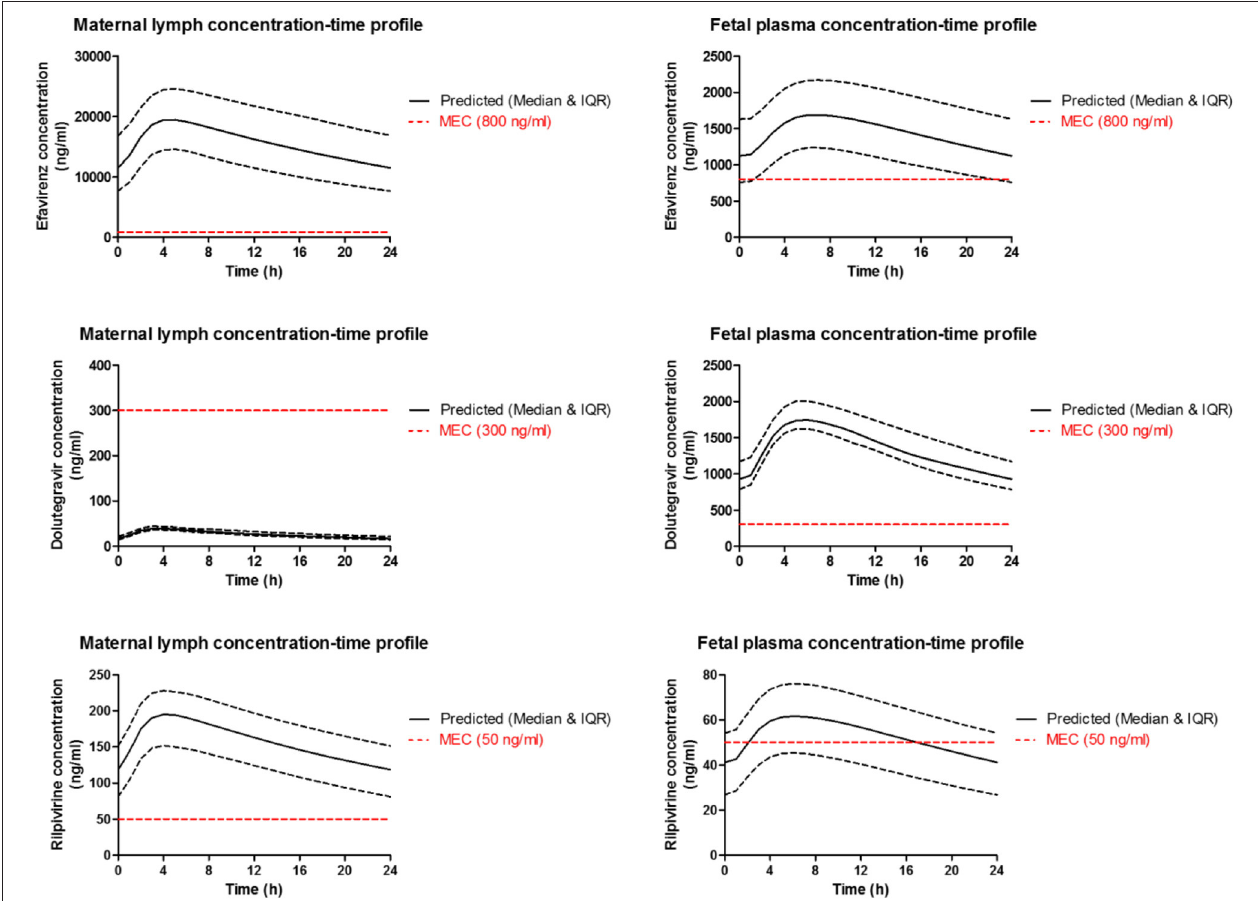
FIGURE 4 | Median (IQR) Predicted maternal plasma and lymph; and fetal plasma concentration-time profile following standard dose of 600mg efavirenz, 50mg dolutegravir, and 25mg rilpivirine in third trimester. Dotted line represent the reported minimum effective concentration (MEC) for each drug at the standard